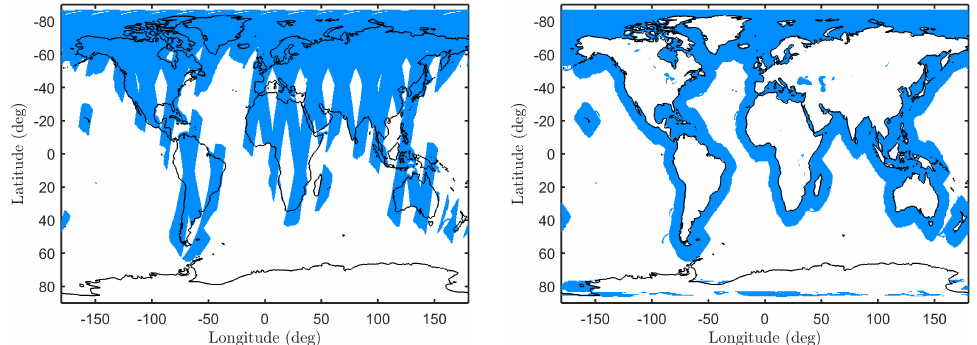
Figure 4. SMAP L1-C global coverage (HH-polarization at fore look direction) highlighted in blue. ( Left ): Daily global coverage on 30 May 2015 (emphasizes individual SMAP passes). ( Right ): Com- posite near-coastal coverage mask for all available